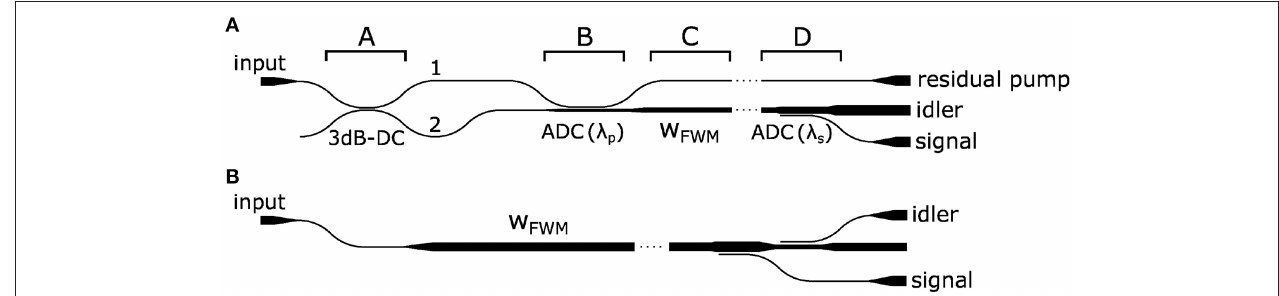
FIGURE 3 | Schematic design of the chip for inter-modal FWM. (A) Design of the chip used for an inter-modal combination of the type 1 aa 1. The various functional chip parts are labeled with capital letters (A,B,C,D). 3dB-DC refers to a 3 dB coupler and ADC to an asymmetric directional coupler. w FWM indicates the multimode waveguide width. (B) Design of the chip used for an inter-modal combination of the type 11 aa